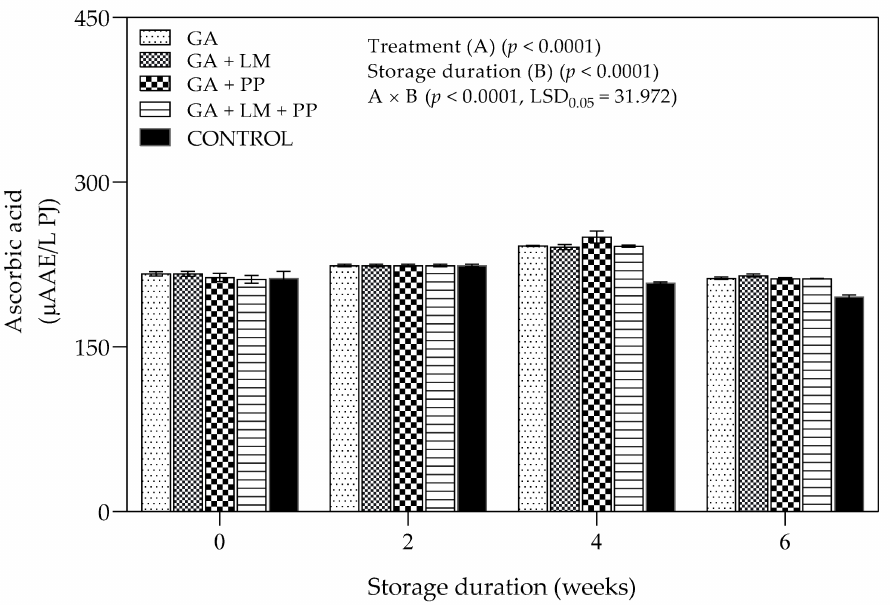
Figure 13. Ascorbic acid ( µ AAE/L PJ) of ‘Wonderful’ pomegranate whole fruit coated with gum arabic (GA) coatings enriched with lemongrass oil (LM) (0.1% v/v ) and/pomegranate peel extract (PP) (1% w/v ) and stored at 5 ± 1 ◦ C (95 ± 2% RH) for 6 weeks followed by 5 d at shelf-life conditions (20 ± 1 ◦ C and 60% RH). Vertical bars represent the standard error (SE) of mean values calculated from three measurements (Aril juice extracted from 10 fruit = 1 replicate = 1 measurement). LSD 0.05 represent least significant difference ( p <